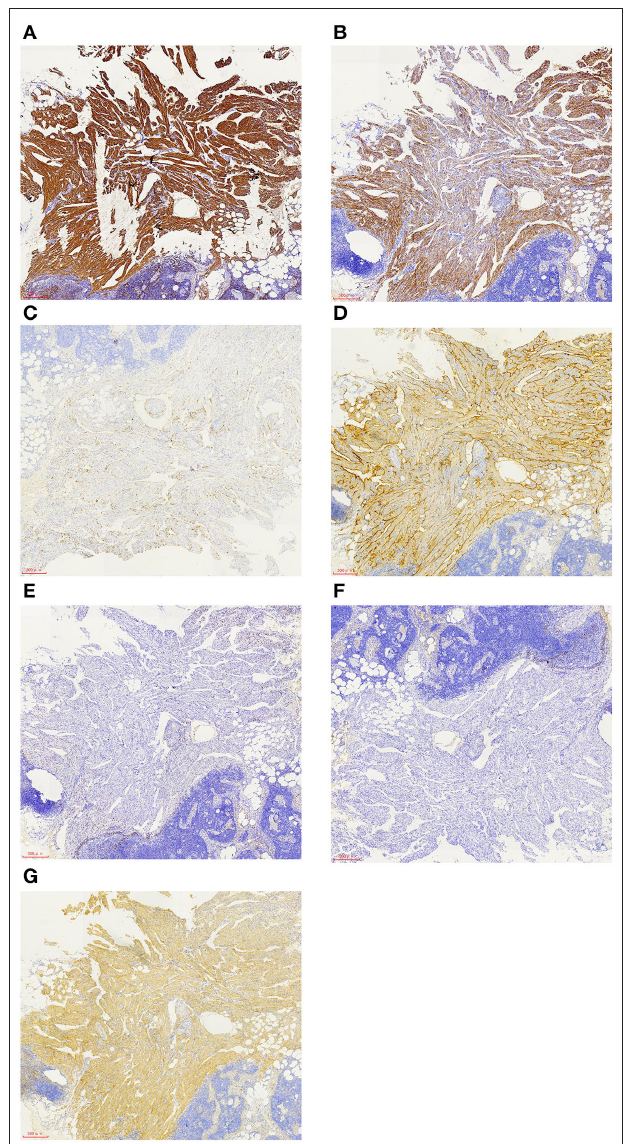
FIGURE 2 | Immunohistochemistry of LAM cells showed that the smooth muscle-like specific protein markers a-SMA (A) and desmin (B) were positive, the melanocyte marker HMB45 was focally positive (C), D2-40 was positive (D), ER and PR were negative (E,F), and β -catenin was positive (G). The scale represents 300 µ m (A – G)